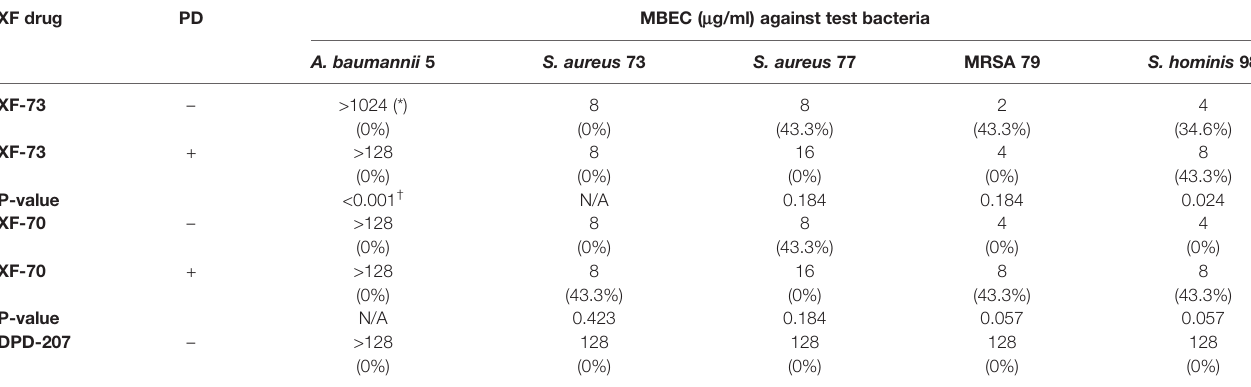
TABLE 3 | Minimum bio fi lm eradication concentrations (MBECs) for